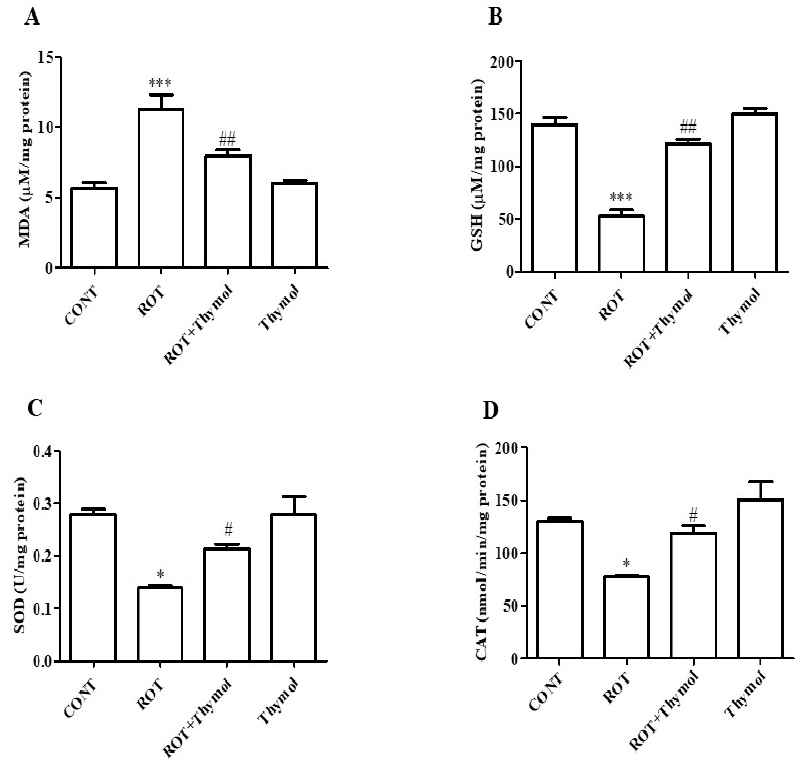
Figure 3. The levels of MDA, GSH and enzymatic activity of SOD and CAT were determined in the mid brain tissues of rats from different experimental groups. ROT treated rats showed significant (*** p < 0.01) increase in MDA ( A ) and decrease in GSH ( B ) levels when compared to control rats. Thymol treatment to ROT administered rats showed significantly (## p < 0.05) decreased level of MDA and increased (## p < 0.01) level of GSH. Moreover, ROT challenge also showed significant (* p < 0.05) decreased enzymatic activity of SOD ( C ) and CAT ( D ) when compared CONT rats. Thymol treatment to ROT challenged rats significantly (# p < 0.05) increased the activities of SOD and CAT when compared to ROT alone injected rats. The values are presented as mean ± SEM ( n = 6–8).